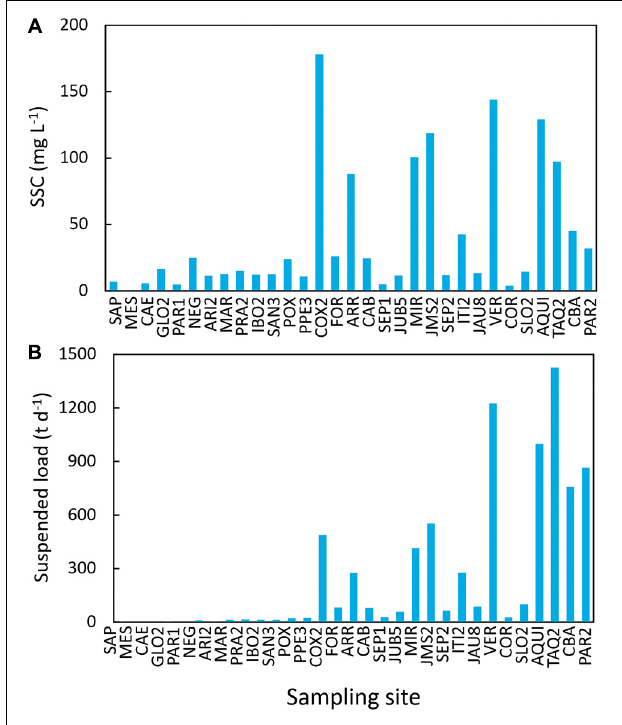
FIGURE 2 | (A) Suspended sediment concentrations (SSC) and (B) loads (transport) in rivers that drain into the Pantanal, for sampling sites below